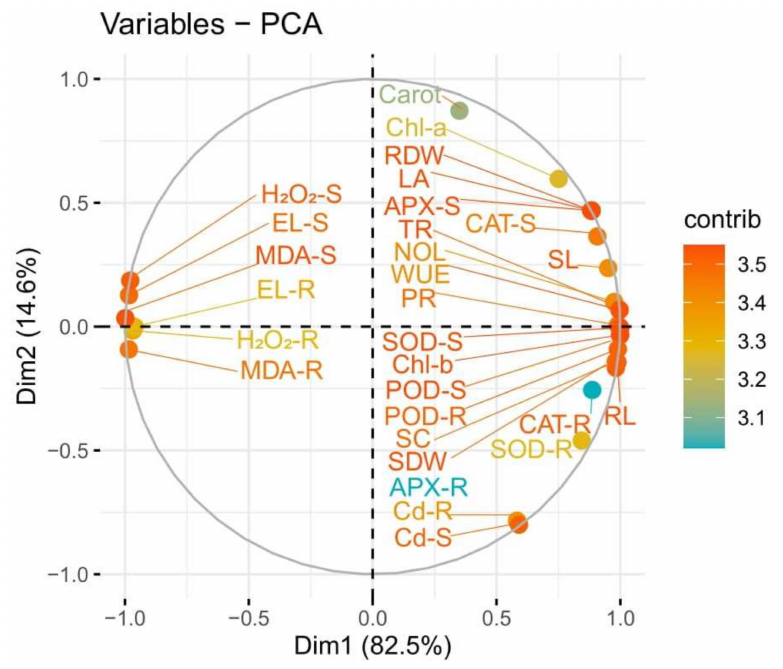
Figure 8. Loading plots of principal component analysis showed a relationship between growth and physiological parameters of S. nigrum grown under Cd contaminated soil with the application of S-Fertilizers. Different abbreviations used in the figure are as follow: Cd-R (Cd concentration in the roots) Cd-S (Cd concentration in the shoots), SL (shoot length), RL (root length), SDW (shoot dry weight), RDW (root dry weight), NOL (number of leaves), LA (leaf area), Chla (chlorophyll a), Chlb (chlorophyll b), Carrot (carotenoid contents), TR (transpiration rate), WUE (water use efficiency), PR (photosynthetic rate), SC (stomatal conductance), POD-S (peroxide activity in the shoots), POD-R (peroxide activity in the roots), SOD-S (superoxidase activity in the shoots), SOD-R (superoxidase activity in the roots), CAT-S (catalase activity in the shoots), CAT-R (catalase activity in the roots), APX-S (ascorbate peroxidase activity in the shoots), APX-R (ascorbate peroxidase in the roots) EL-S (electrolyte leakage in the shoots), EL-R (electrolyte leakage in the roots), H 2 O 2 -S (hydrogen peroxide content in the shoots), H 2 O 2 -R (hydrogen peroxide content in the roots), MDA-S (malondialdehyde contents in the shoots) and MDA-R (malondialdehyde contents in the